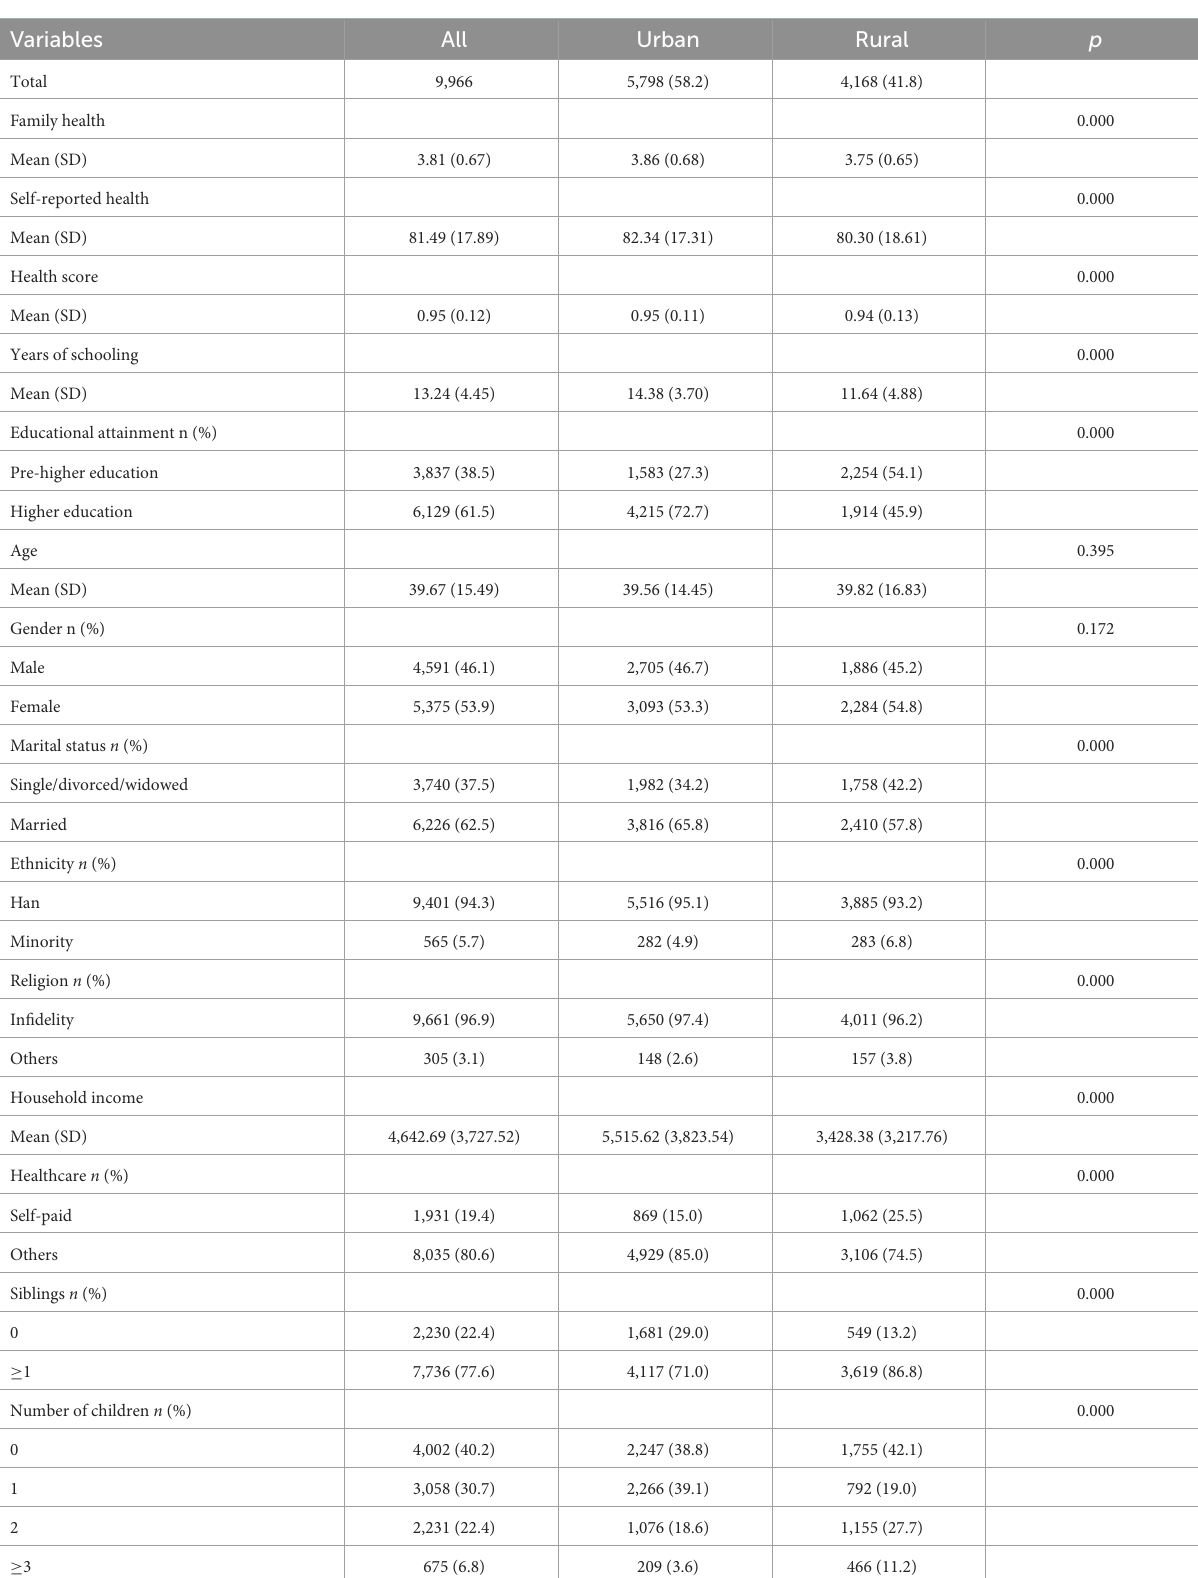
TABLE 1 Descriptive statistics and univariate